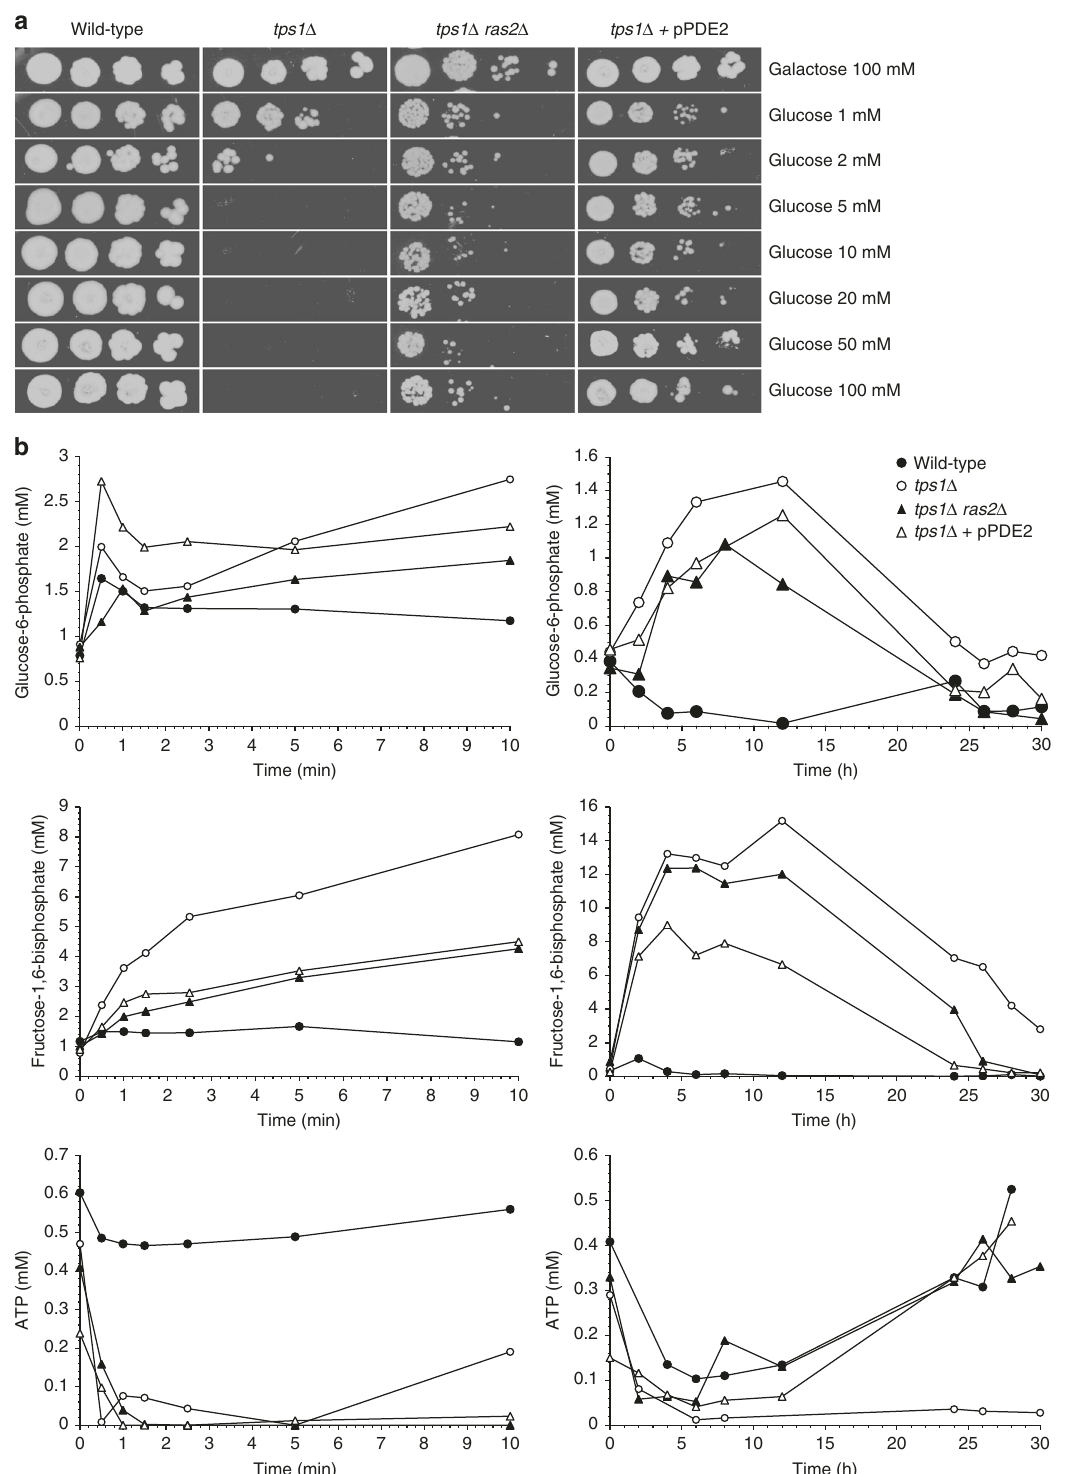
Fig. 3 Restoration of growth on glucose and glycolytic metabolite levels in the tps1 Δ strain with downregulation of the Ras-cAMP-PKA pathway. a Growth of tps1 Δ and suppressor strains on galactose and different concentrations of glucose. Five-fold dilutions were spotted. b Intracellular Glu6P, Fru1,6bisP and ATP concentration before and after addition of 100 mM glucose. The short-term measurements (0 – 10 min) were performed with non-growing cells incubated in 25 mM MES buffer (pH 6.0), while the long-term measurements (0 – 30 h) were performed with cells growing in minimal galactose